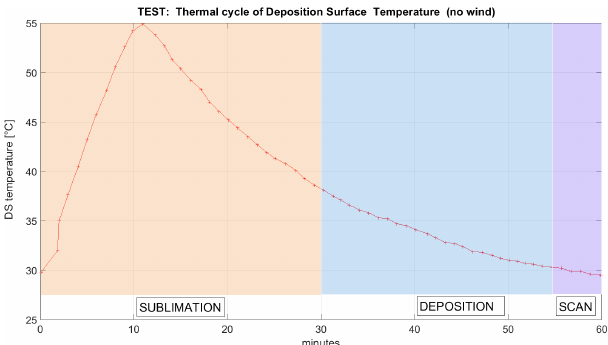
Figure 7. Indoor test of DS heating and cooling within a 60min cycle. For reasons of simplicity, the periods of sublimation and de- position are well